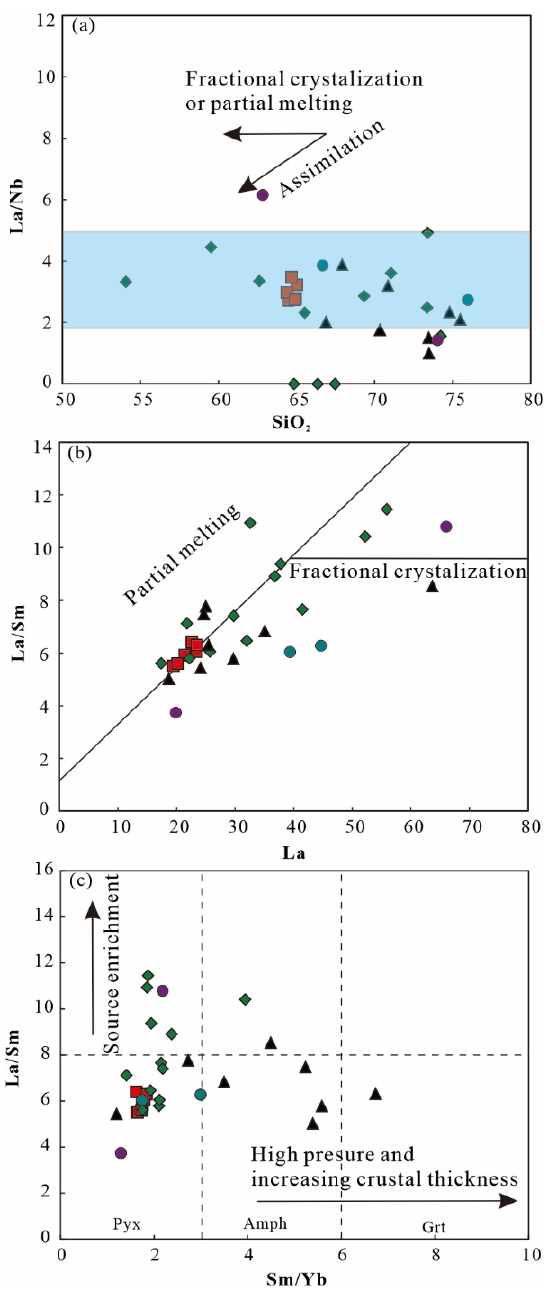
Figure 8. ( a ) La/Nb vs. SiO 2 diagram; ( b ) La/Sm vs. La diagram; ( c ) La/Sm vs. Sm/Yb diagram [60]. Data are from the same source as Figure 5.